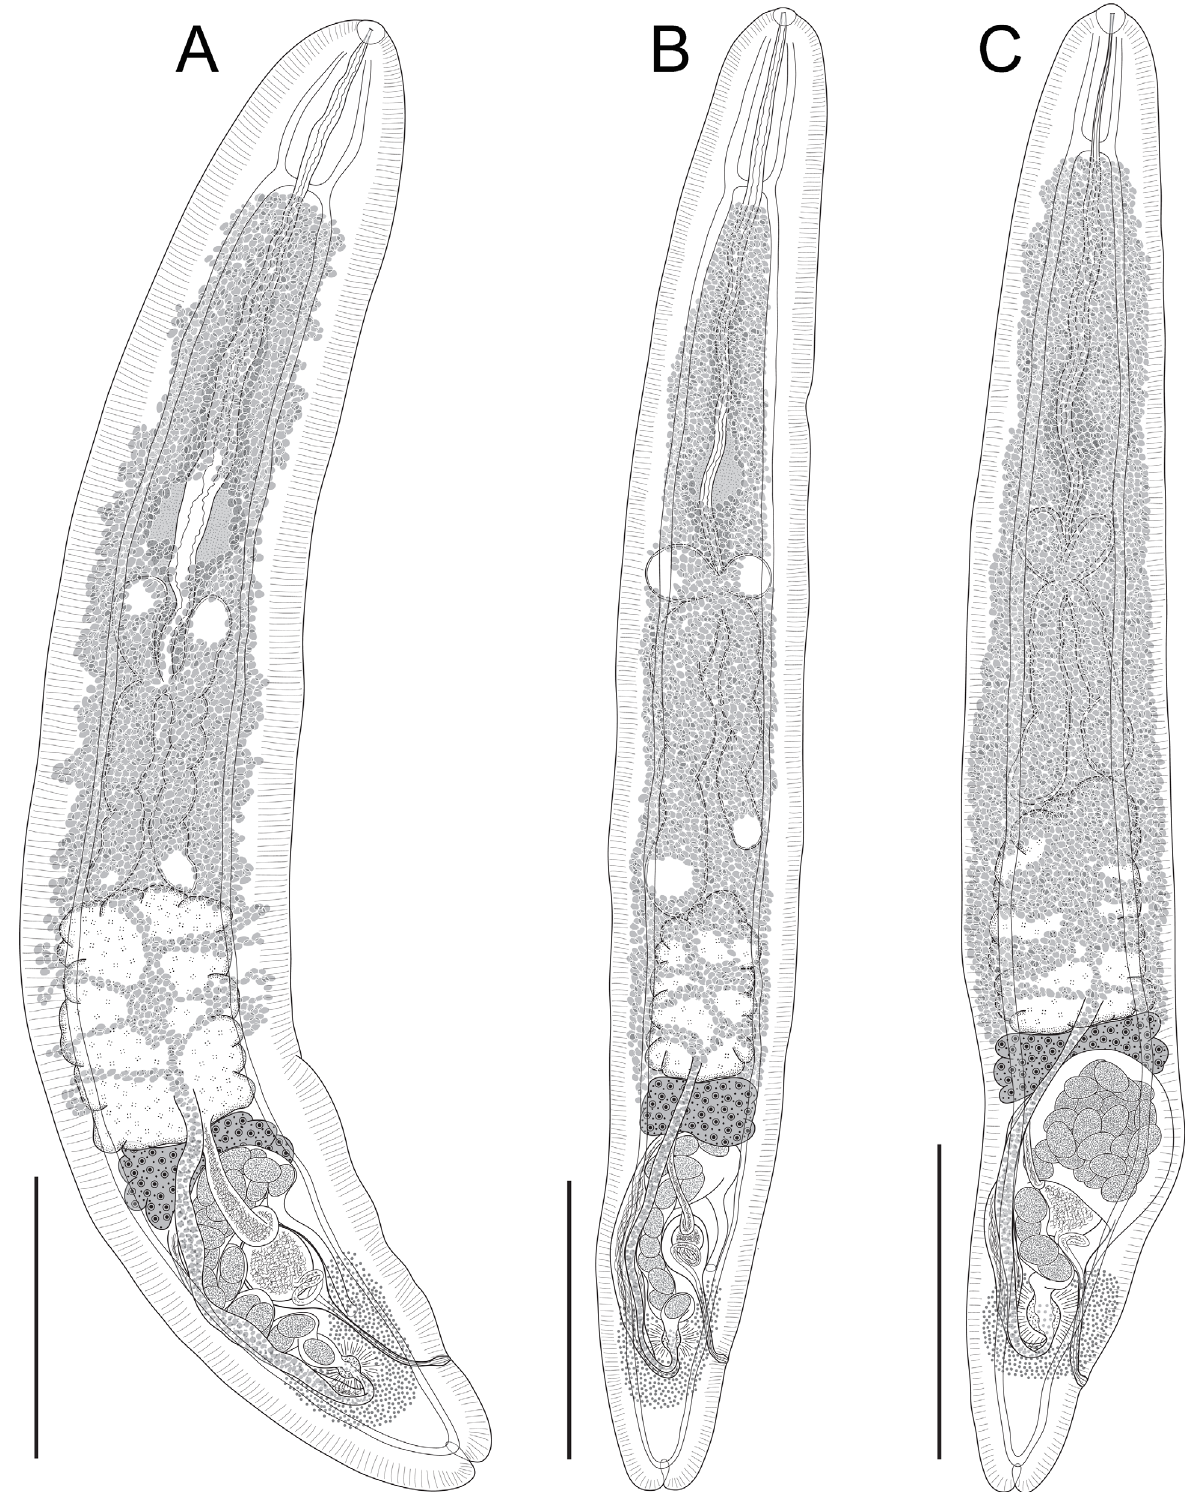
Figure 2. Species of Holocentricola from Great Barrier Reef Holocentridae, whole worms, ventral views. (A) Holocentricola rufus n. sp. ex Sargocentron rubrum from off Heron Island (holotype, QM G239429); (B) Holocentricola exilis n. sp. ex Neoniphon sammara from off Lizard Island (paratype, QM G239111); (C) Holocentricola coronatus n. sp. ex Sargocentron diadema from off Lizard Island (holotype, QM G239125). Scale-bars: A – C, 200 l